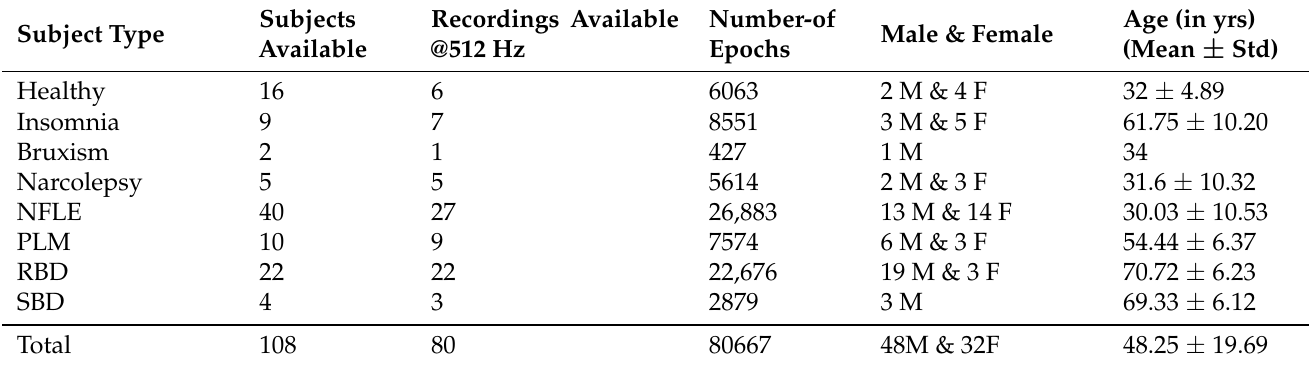
Table 2. Description of the cyclic alternating pattern (CAP) sleep database.